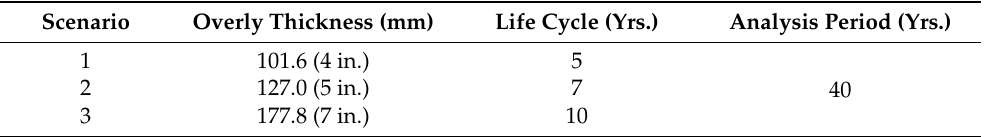
Table 2. Scenarios for implementing rubberized concrete and ordinary concrete in Texas, U.S.